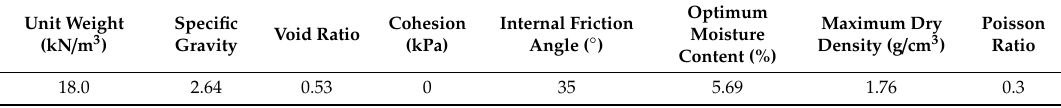
Figure 2. Model box and installation of earth pressure cell.